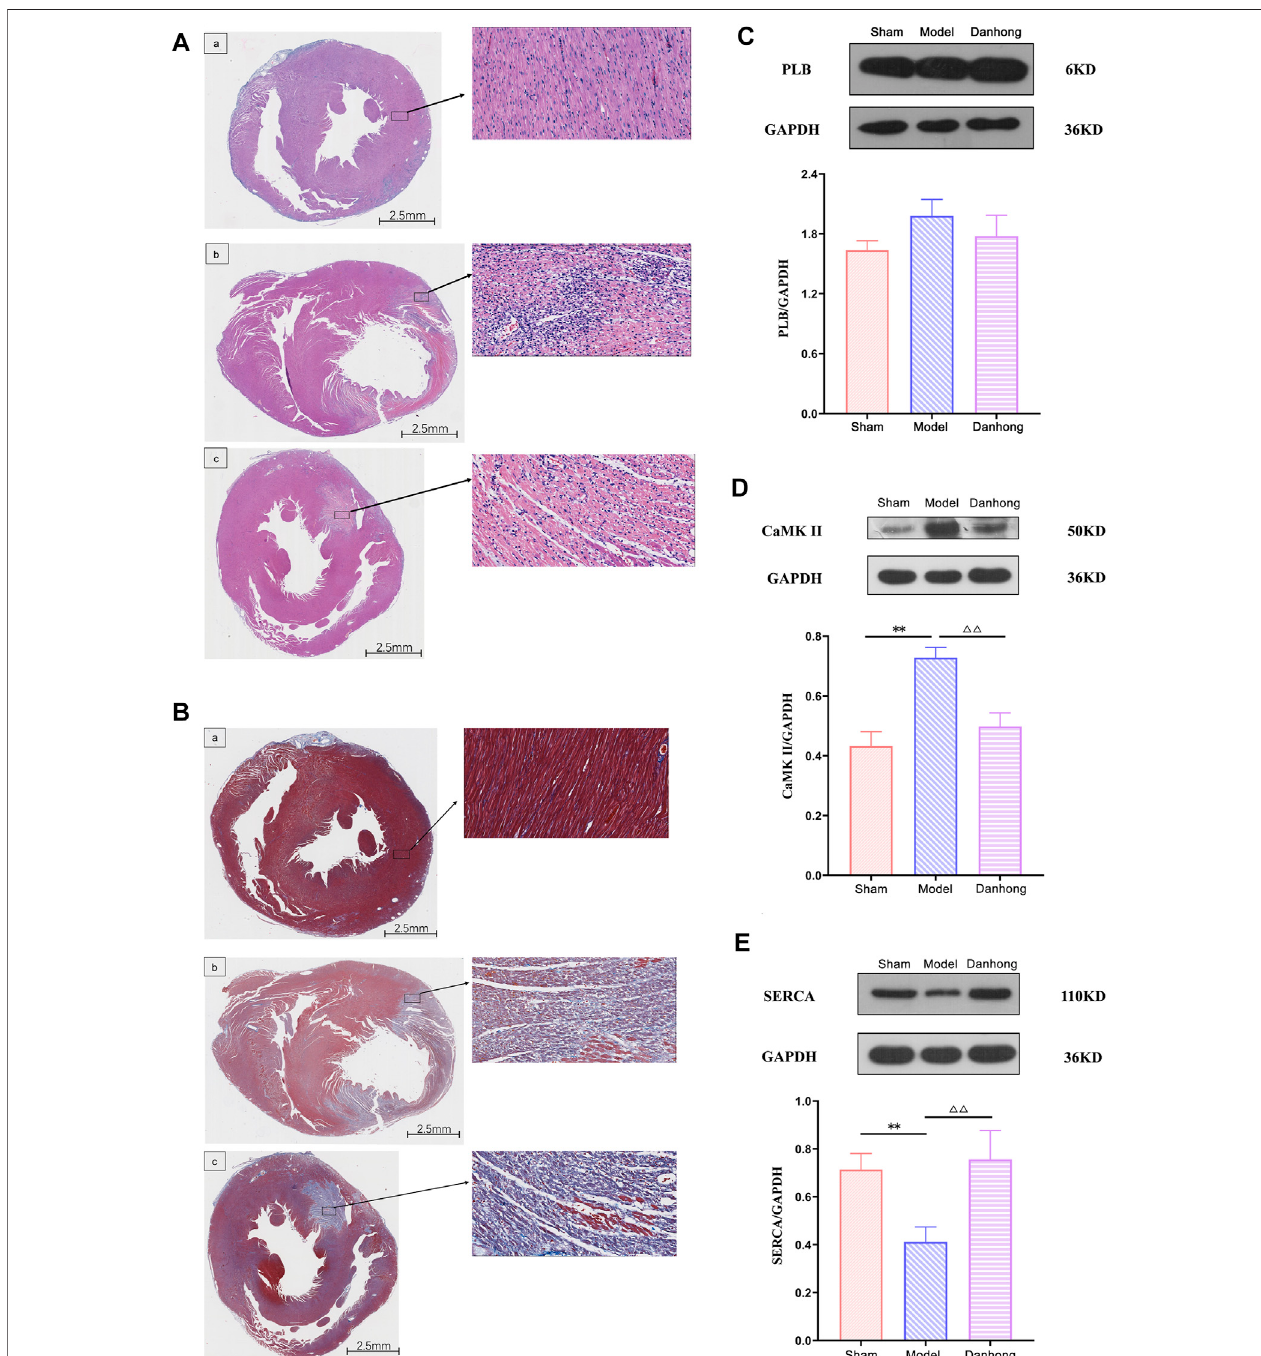
FIGURE 9 | (A) The effect of DHI on AMI model rats (HE staining). a: sham group; b: model group; c: DHI 6 mg/kg group. (B) The effect of DHI on AMI model rats (Massonstaining).a:shamgroup;b:modelgroup;c:DHI6 mg/kggroup. (C) EffectofDHIontheexpressionofPLBproteininthemyocardiumofAMImodelrats( n =3, (cid:1) x ±s).** p < 0.01vs.sham; △△ p < 0.01vs.model. (D) EffectofDHIontheexpressionofCaMKIIproteininthemyocardiumofratswithAMI( n =4, (cid:1) x ±s).** p < 0.01vs.sham; △△ p < 0.01 vs. model. (E) Effect of DHI on the expression of SERCA protein in the myocardium of rats with AMI ( n = 4, (cid:1) x ±s). ** p < 0.01 vs. sham; △△ p < 0.01 vs. model. 14 Table